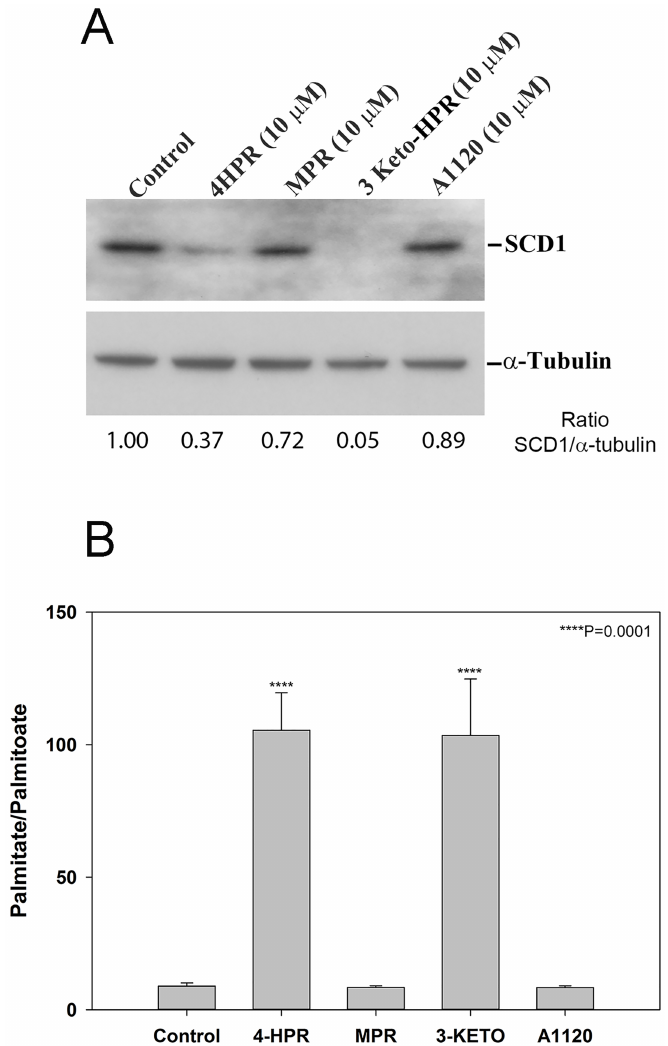
Fig 2. Effect of fenretinide and its metabolites on SCD expression and activity. A) SCD1 protein expressionis decreasedafter treatment with fenretinide,and its metabolite3-keto-HPR. ARPE-19 cells were treated with the indicatedconcentration of fenretinide,its metabolites, A1120, or vehiclefor 24 h. Cell lysates were analyzedby Western blotting using mouse monoclonal antibody againstSCD1 (upper panel)in comparisonwith immunoreactivity to α -tubulin which was employedas a loadingcontrol (lower panel)and densitometry for each lane was performed and analyzedby ImageJ to provide the SCD1/ α -tubulin ratio for each lane. B) SCD1 protein activity is decreased after treatment with fenretinide,and its metabolite3-keto- HPR. ARPE-19 cells were treated with the indicatedconcentration of fenretinide,its metabolites, A1120, or vehiclefor 16 h, then incubatedan additional5 h in the presenceof methyl D3-palmitic acid (50 μ M) before harvesting. Free fatty acids present in lipid extracts were analyzedby LC/MS and SCD1 activity, measuredby the conversionof methyl-D3 palmitic acid to methyl-D3 palmitoleicacid, was determined. Fenretinideand 3-keto-HPR are effective inhibitorsof SCD1 activity, whereasMPR and A1120 have no inhibitoryeffect on SCD1 activity at all. Lipids were extracted from two 100 mm Petri dishes and combinedfor mass spectrometry analysis. Data plotted as means ± standarddeviation; n = 3.